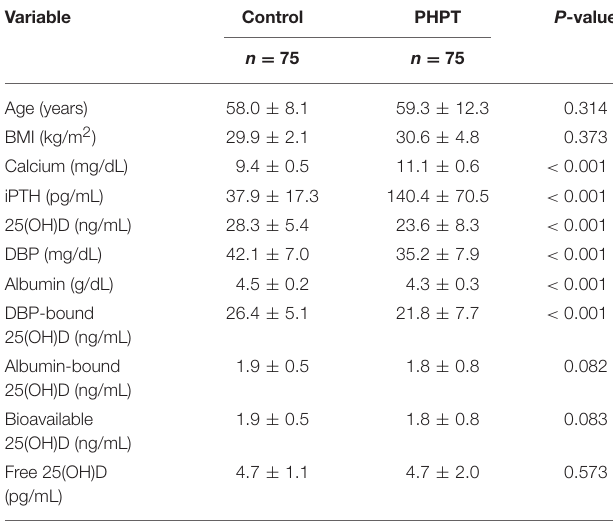
TABLE 1 | Subject characteristics and serum